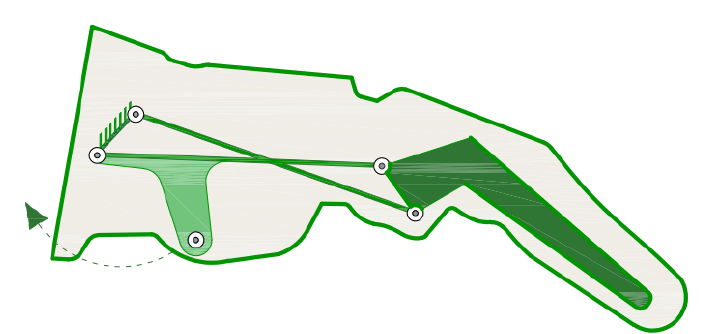
Figure 2. Finger movement mechanism through rigid connections. Distal and middle phalanges do not allow for relative